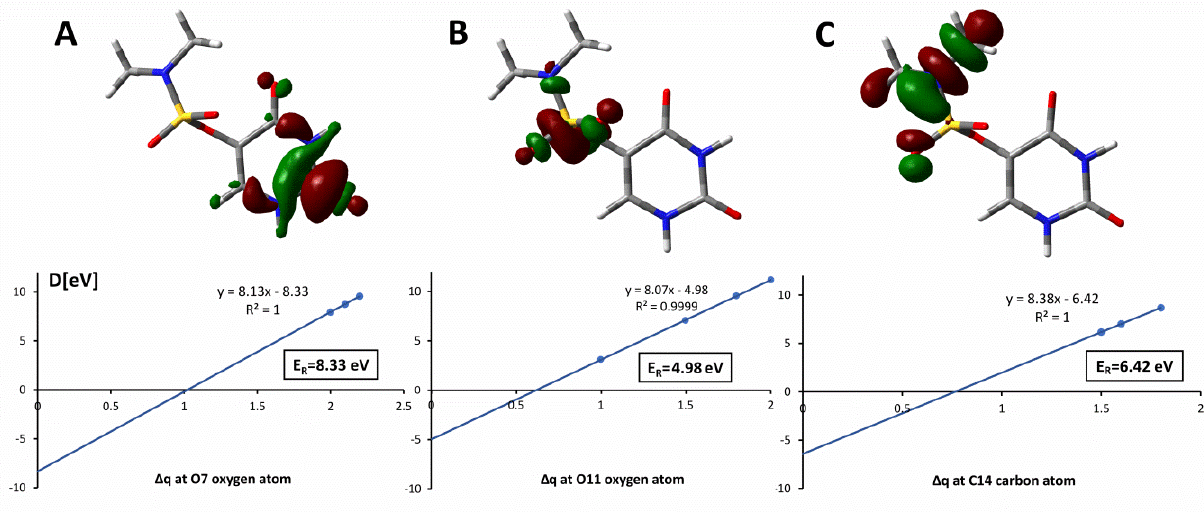
Figure 5. Binding energy, D, plotted at the stabilizing charge, Δq, values for which the anion is electronically stable and extrapolated to Δq → 0. Singly occupied molecular orbital (SOMO) visualized with the contour value of: 0.05 (a 0 ) −3/2 for Δq = 2.1 (A panel); 0.08 (a 0 ) −3/2 for Δq = 1.5 ( B ) and 0.05 (a 0 ) −3/2 for Δq = 1.6 ( C ). E R stands for the position of resonance related to the release of: O7 ( A ), O11 (B) or the C(14)H 3 methyl group (C).